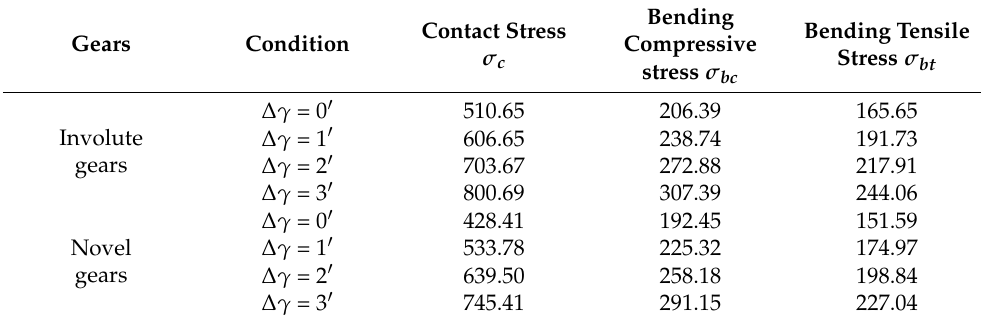
Figure 19. Comparison of contact stress between novel gears and involute gears with different misalignment errors. ( a ) Unmodified involute gears; ( b ) Unmodified novel gears; ( c ) Modified involute gears; ( d ) Modified novel gears. Table 4. Comparison of maximum stress between unmodified novel gears and unmodified involute gears with different misalignment errors